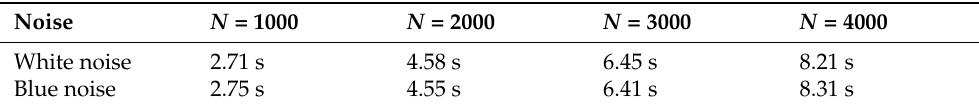
Table 1. Running time comparison of RCMFDE different N . Noise White